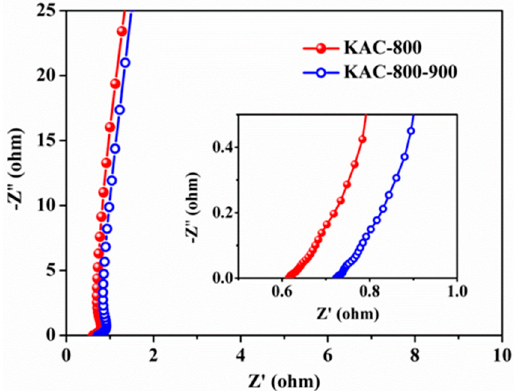
Figure 9. Impedance Nyquist plots of KAC-800 and KAC-800-900 (inset enlarged high-frequency region of Nyquist plots).